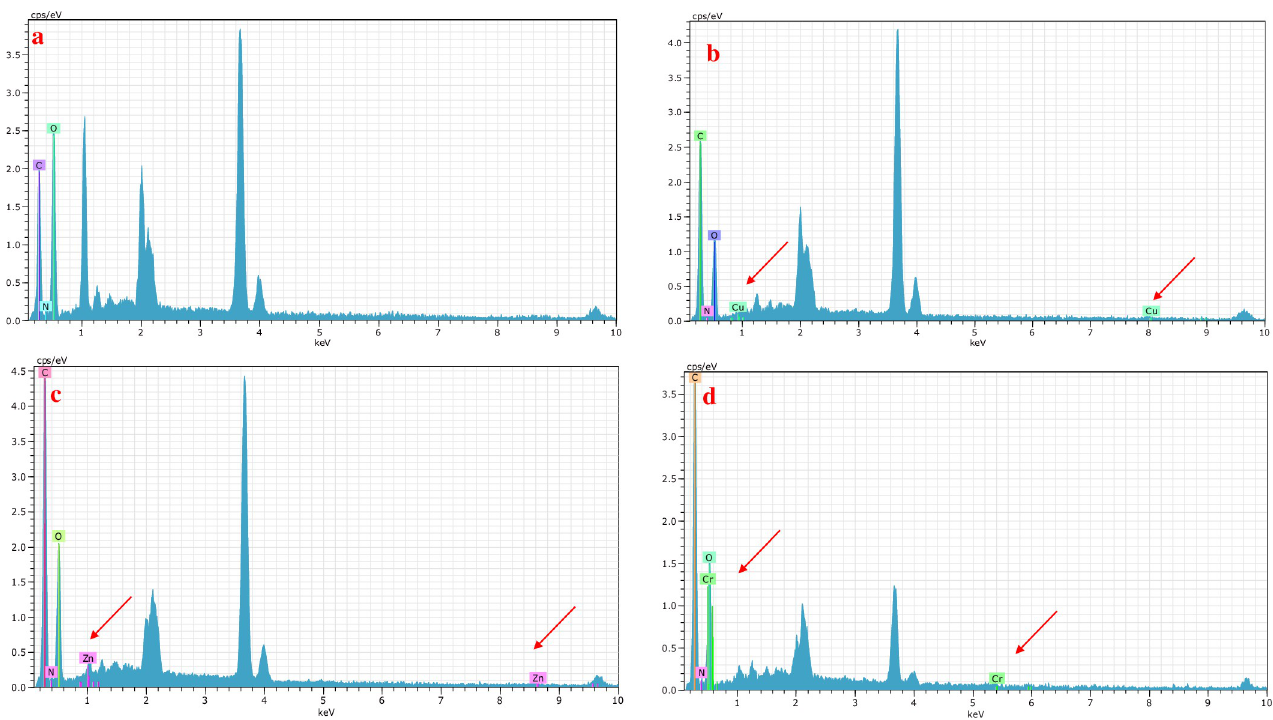
Fig 4. (a) EDX images of Imine before adsorption, (b-d) after adsorption of Cu(II), Zn(II), and Cr(III) onto